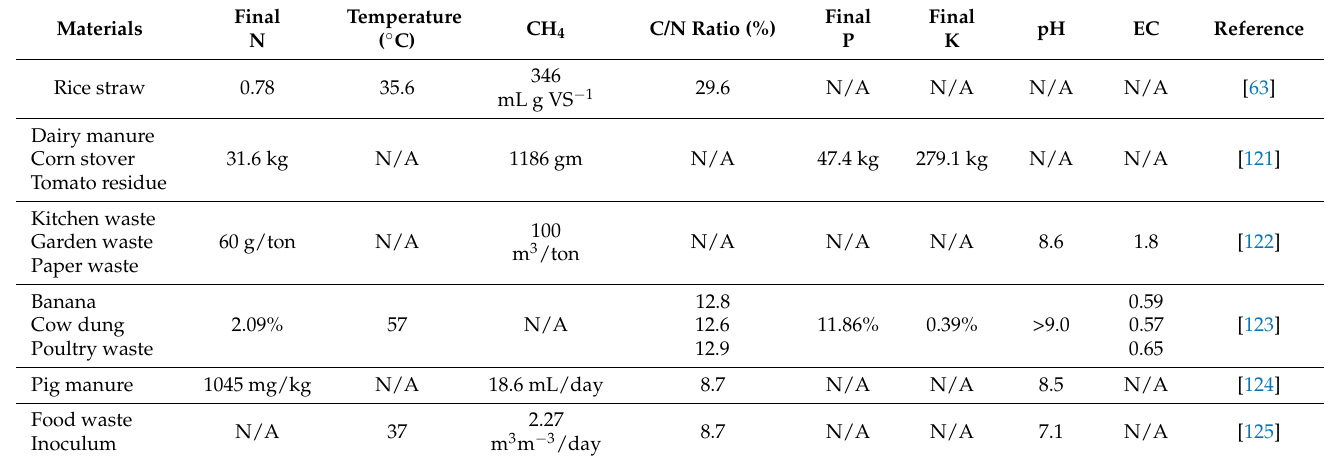
Table 7. Chemical properties of different